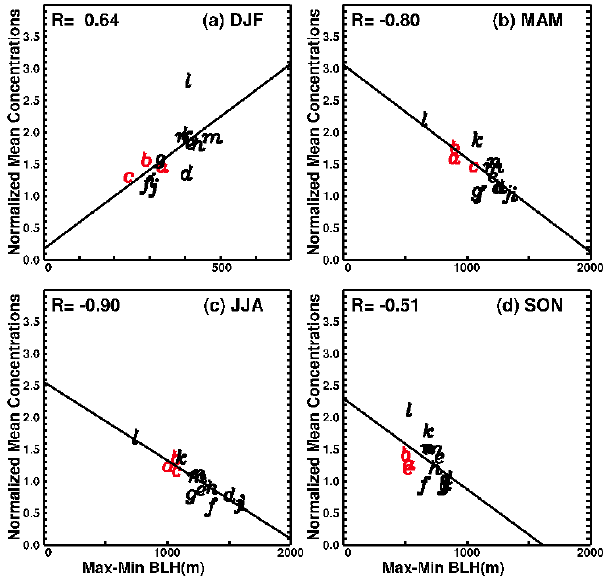
Fig. 8. Scatter plot showing seasonal mean of simulated concen- trations divided by measured concentrations and seasonally aver- aged diurnal amplitude of boundary layer height in Heidelberg in 2002. Correlations and regression line were estimated for each sea- son (a) December, January and February, (b) March, April and May, (c) June, July and August, and (d) September, October and Novem- ber. Each letter corresponds to a model listed in Table 1. See text for details of seasonal variations of a group (a, b, c) colored in